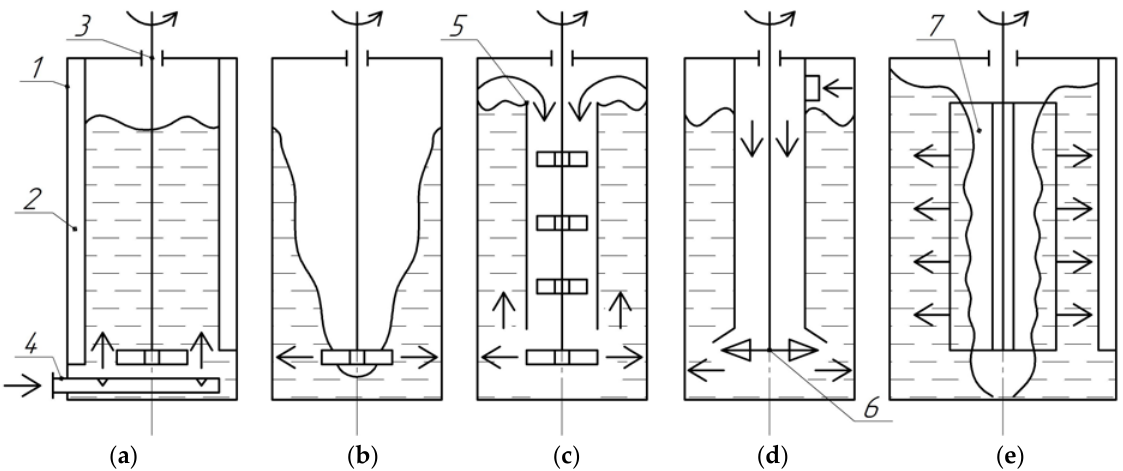
Figure 1. Different methods for dispersing gas into a liquid in a stirrer apparatus: 1—housing; 2—partition; 3—shaft; 4—bubbler; 5—circulation tube; 6—self-priming stirrer; 7—stirrer paddle; gas supply through ( a – e ): ( a ) bubbler; ( b ) surface vortices; ( c ) circulation circuit; ( d ) self-priming stirrer; ( e ) low pressure zones behind the paddle.